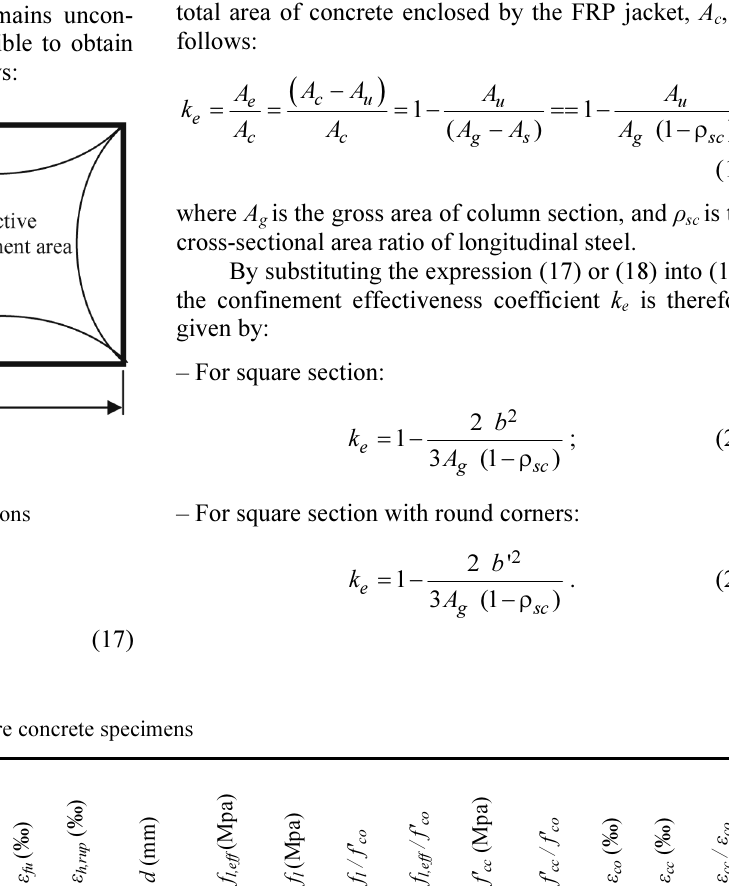
Concrete mixture